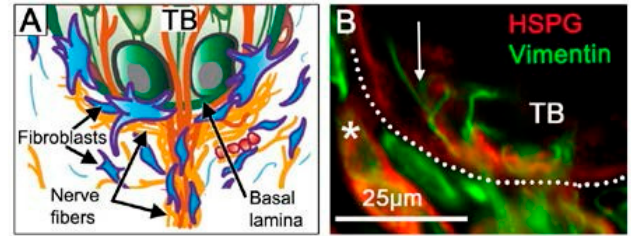
Figure 5. Basal lamina niche region under the taste bud and at the apex of the fungiform papilla connective tissue core. ( A ) Diagram for structural interactions among nerve fibers, fibroblasts and lamellipodia, and taste bud (TB) cells, at the basal lamina (Adapted from Figure 4 in Mistretta and Kumari (2017) [13] with permission) ( B ) Photomicrograph of basal lamina (HSPG immunoreaction, red) under TB cells with lamellipodia extensions (arrow) across the basal lamina from fibroblasts (Vimentin immunoreaction, green). The dotted line demarcates the basal epithelium. The asterisk denotes labelling of blood vessel basal lamina. We propose that Shh is sequestered at the basal lamina in this niche region.